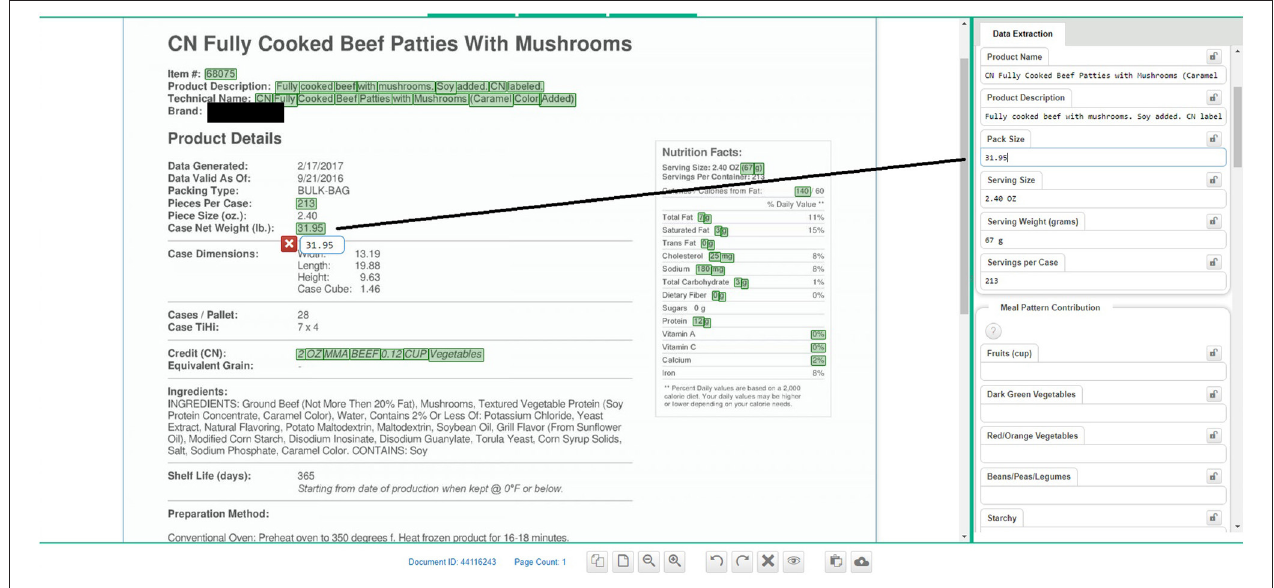
FIGURE 4 | Example of automatic detection and extraction in a page by the